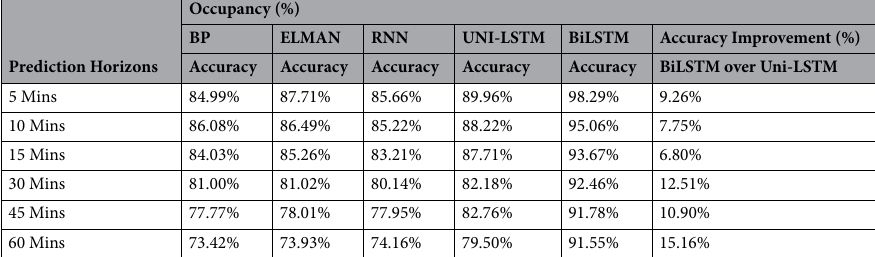
Table 5. Occupancy performance for different prediction horizons.